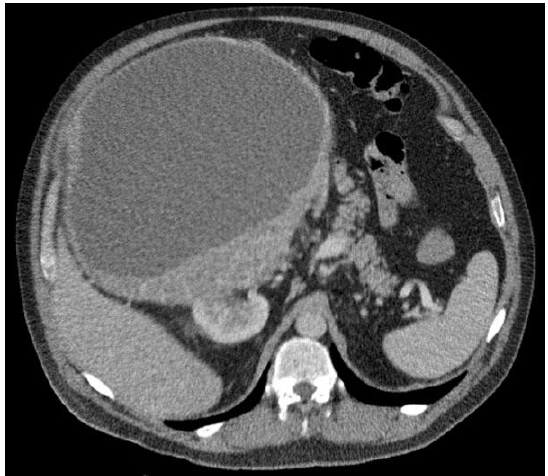
FIGURE 1. Transaxial CT scan image of large right renal cystic mass with enhancing peripheral rim.